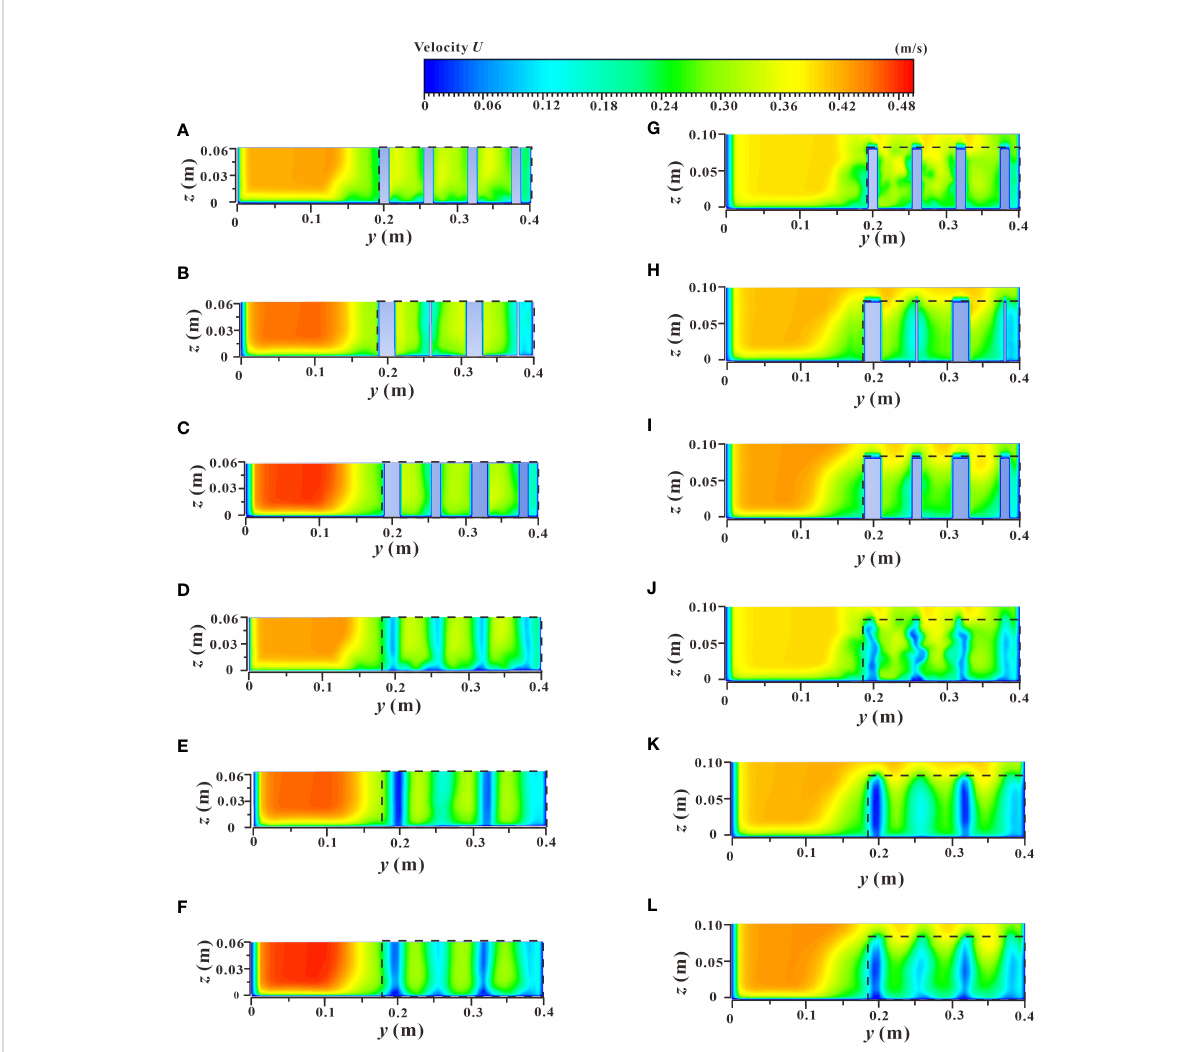
FIGURE 11 Spatial distribution of velocity contours of xz sections under different submerged states. (A) C 1 , h = 0.06 m, d & D = 0.012 m & 0.012 m, non- submerged vegetation, (B)